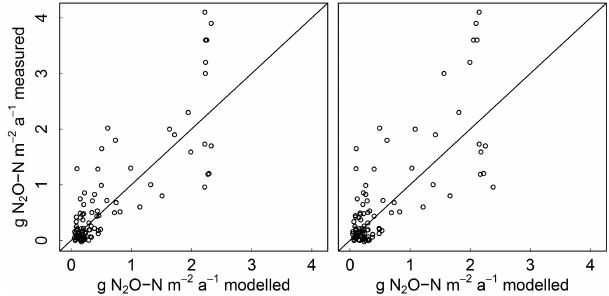
Figure 5. Fuzzy model results for calibration and cross validation for N 2 O fluxes from grassland on organic soils. The modelled fluxes ( x axis) represent the mean flux rates from a model ensemble of 50 individually bootstrapped models. The cross validation was per- formed by excluding one site per